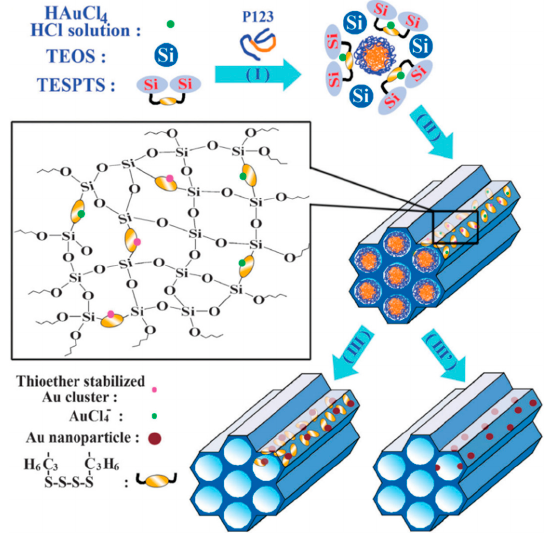
Figure 11. Formation of Au species during the one-pot synthesis process: ( I ) mixing of all reaction precursors in one pot; ( II ) hydrothermal treatment at 100 ° C for 24 h; ( III ) ethanol extraction followed by H 2 reduction; and ( III ′ ) calcined at high-temperature [133].